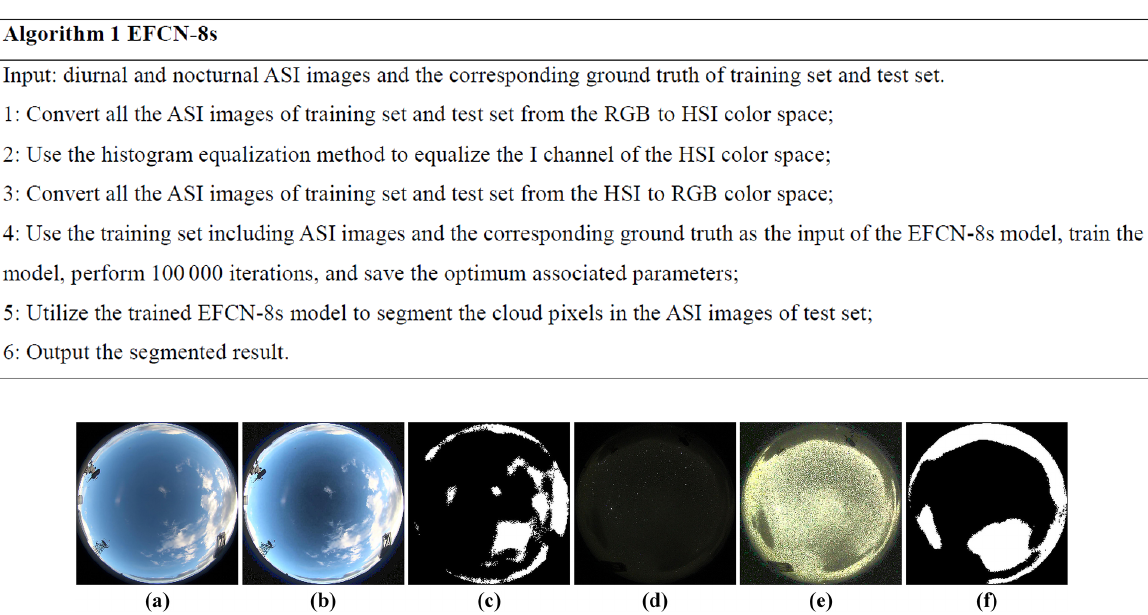
Figure 5. Framework of the complete proposed automatic cloud segmentation based on EFCN-8s. (a) Original diurnal ASI image from the test set, which is the input test image of the EFCN-8s. (b) Enhanced diurnal ASI image using the histogram equalization, (c) diurnal cloud segmentation result using the trained EFCN-8s, (d) original nocturnal ASI image from the test set, which is the input test image of the EFCN-8s, (e) enhanced nocturnal ASI image using the histogram equalization, and (f) nocturnal cloud segmentation result using the trained